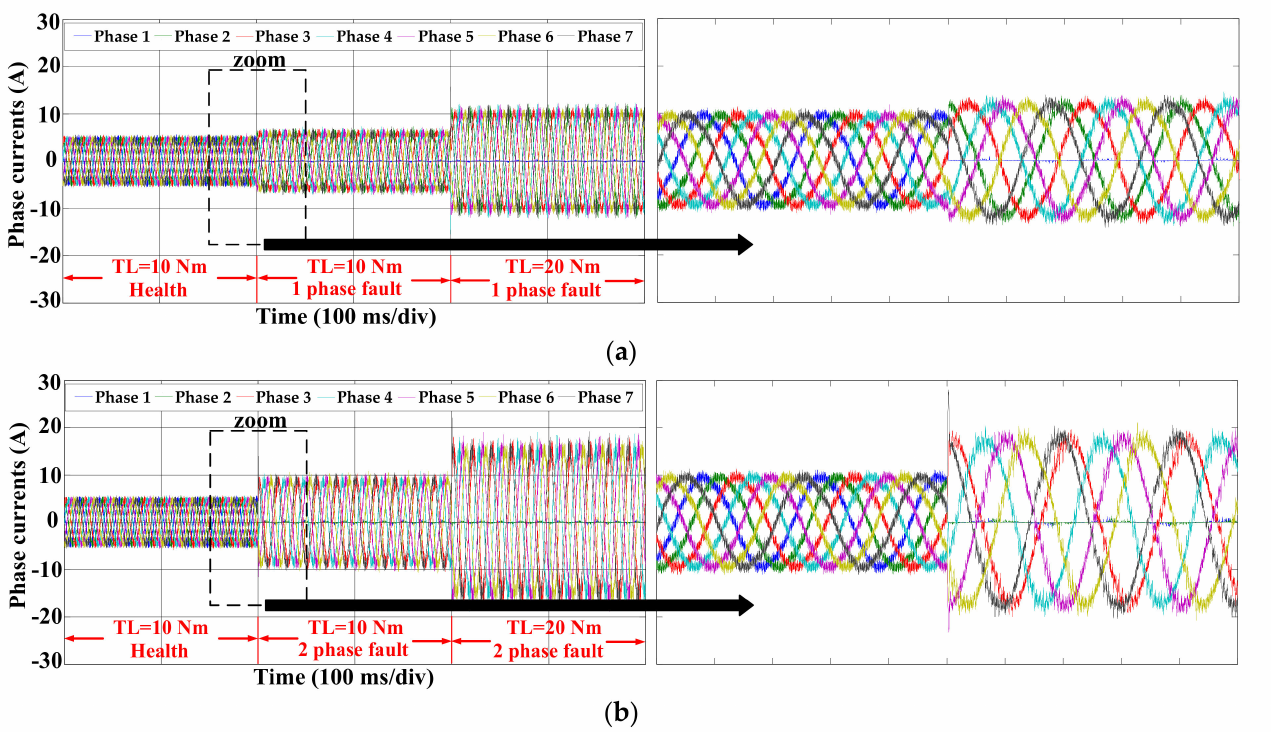
Figure 4. Currents performance for torque step response. ( a ) 1 phase fault (fault 1); ( b ) 2 phases fault (fault